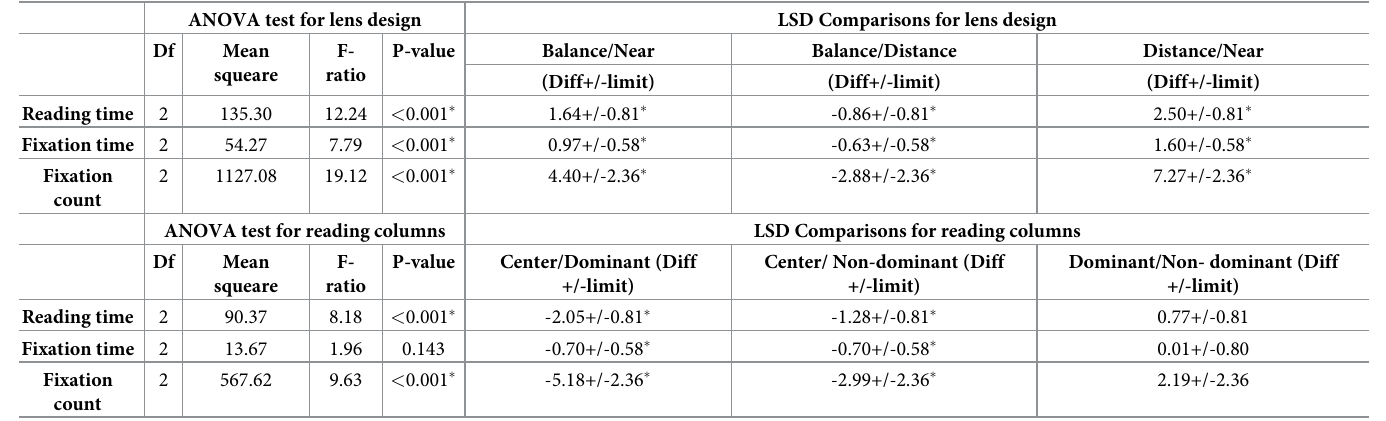
Table 3. Detailed statistics for Fig